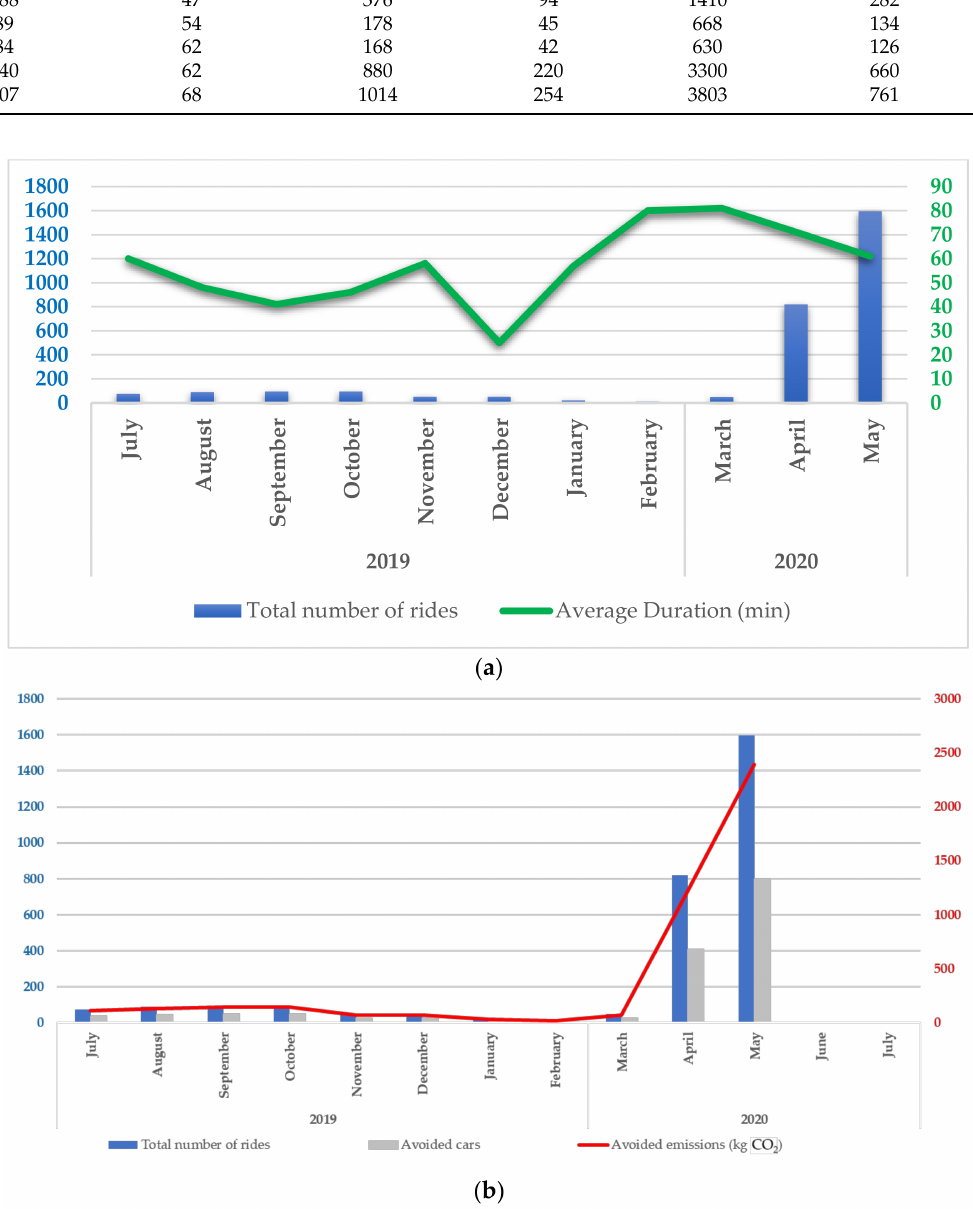
Figure 7. ( a ) Combo chart for Rhode’s BS system relating number of rides per month and avoided cars to number of avoided km. ( b ) Combo chart for Rhode’s BS system relating number of rides per month and avoided cars to number of avoided emissions (kg of CO 2